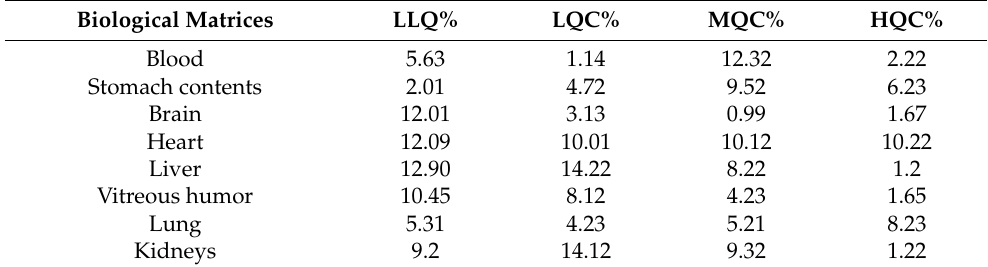
Table 9. Lower limit of quantification (LLQ), low-quality control (LQC), medium-quality control (MQC), and high-quality control (HQC) calculated in each matrix, in triplicate, intracutaneous and intercurrent to aldicarb–sulfoxide.